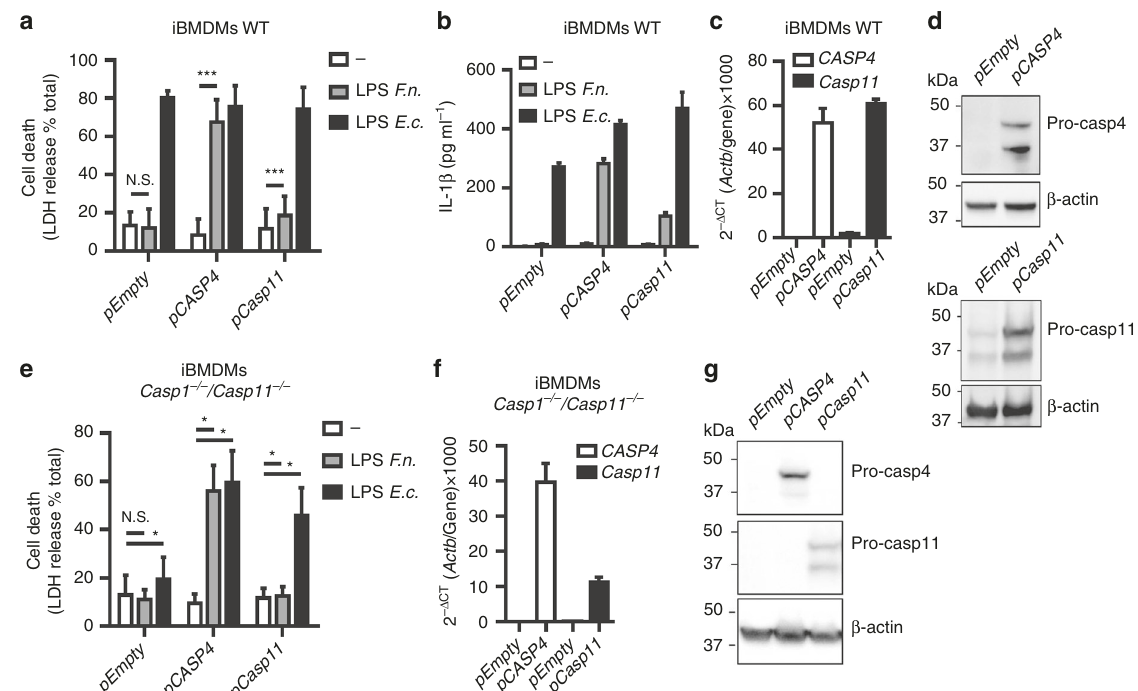
Fig. 5 The human-speci fi c sensing of F . novicida LPS is due to intrinsic properties of caspase-4. a , b WT or e Casp1 − / − /Casp11 − / − iBMDMs expressing the indicated constructs were electroporated with buffer only ( − ) or with 5 µ g of F . novicida ( F.n .) or E. coli lipopolysaccharide (LPS) ( E.c .) LPS. a , e Cell death and b IL-1 β levels were quanti fi ed at 4 h post-electroporation by ELISA and lactate dehydrogenase (LDH) assay, respectively. c , f The levels of the indicated transcripts in transduced immortalized bone marrow-derived macrophages (iBMDM) were assessed by qRT-PCR. d , g Ectopic expression of caspase-4 and -11 were veri fi ed by Western blot. a , b , e Mean values ± SD from a three and e fi ve independent experiments, or from b three technical replicates from one experiment representative of three independent experiments and two-tailed p values with the following nomenclature (*** p < 0.001 and * p < 0.05 by paired t -test) are shown. N.S. not signi fi cant. c , f Mean values ± standard deviation from three technical replicates are